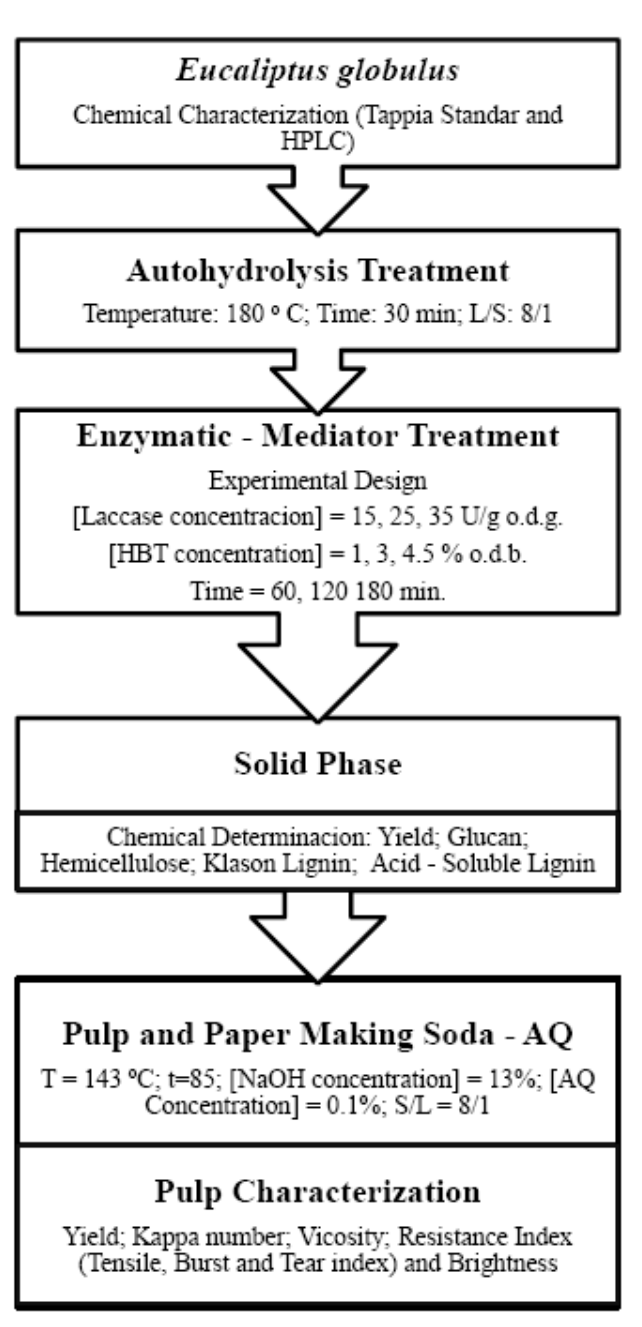
Figure 1. Scheme of experimental work.